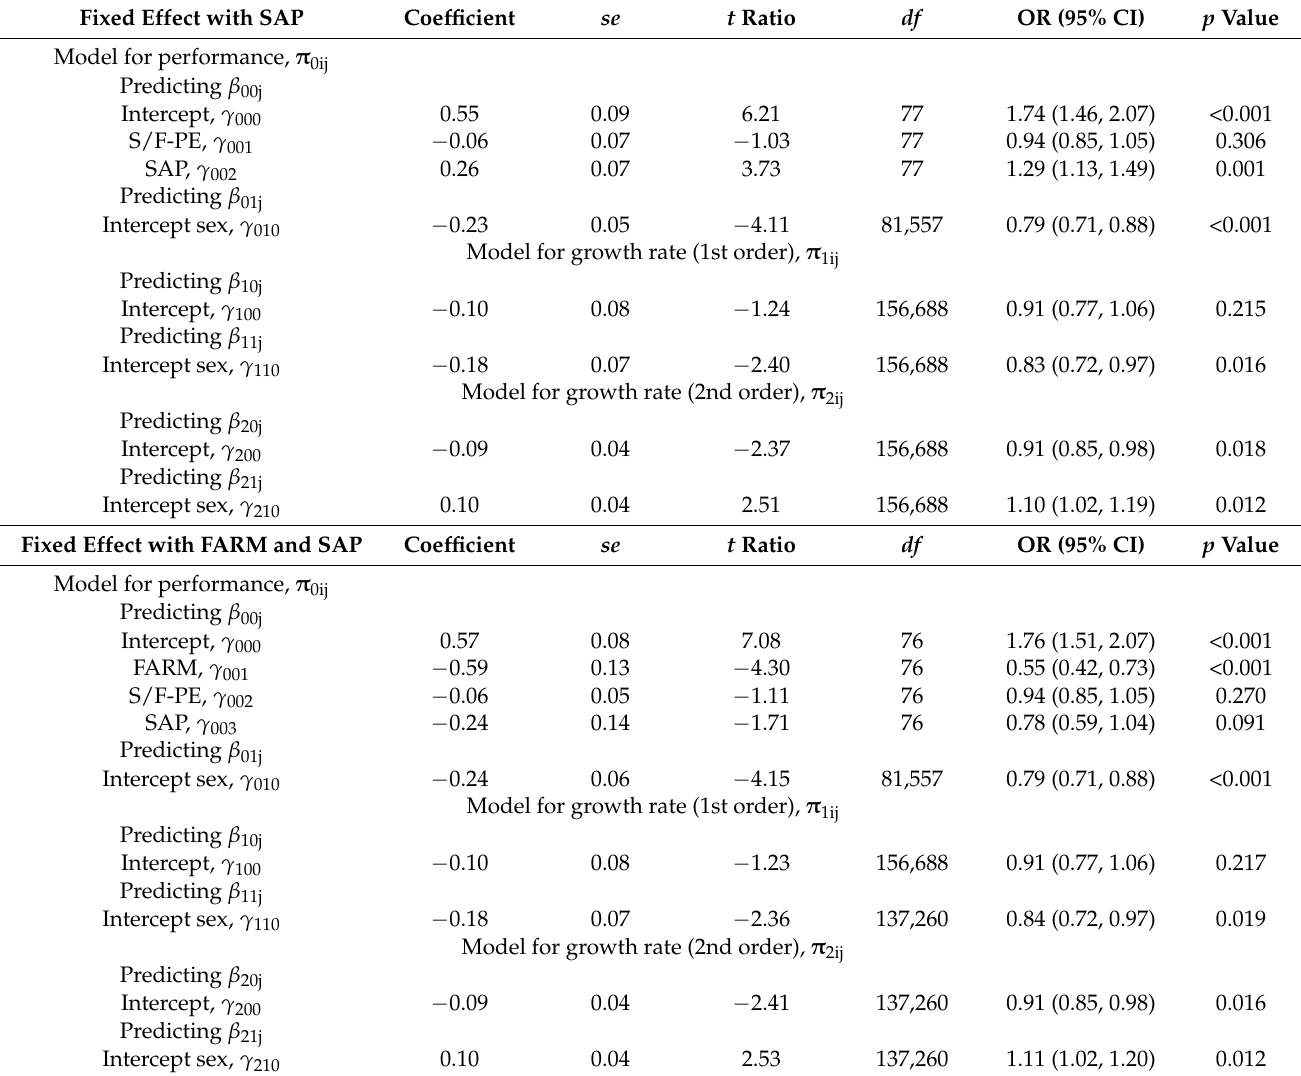
Table 2. Youth PACER performance changes through ninth to twelfth